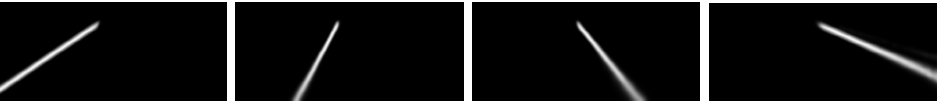
Figure 6. Predicted lane line probability pictures. We can see that different lane lines are predicted for different feature map channels, and some key points are selected and reconnected to obtain the final prediction